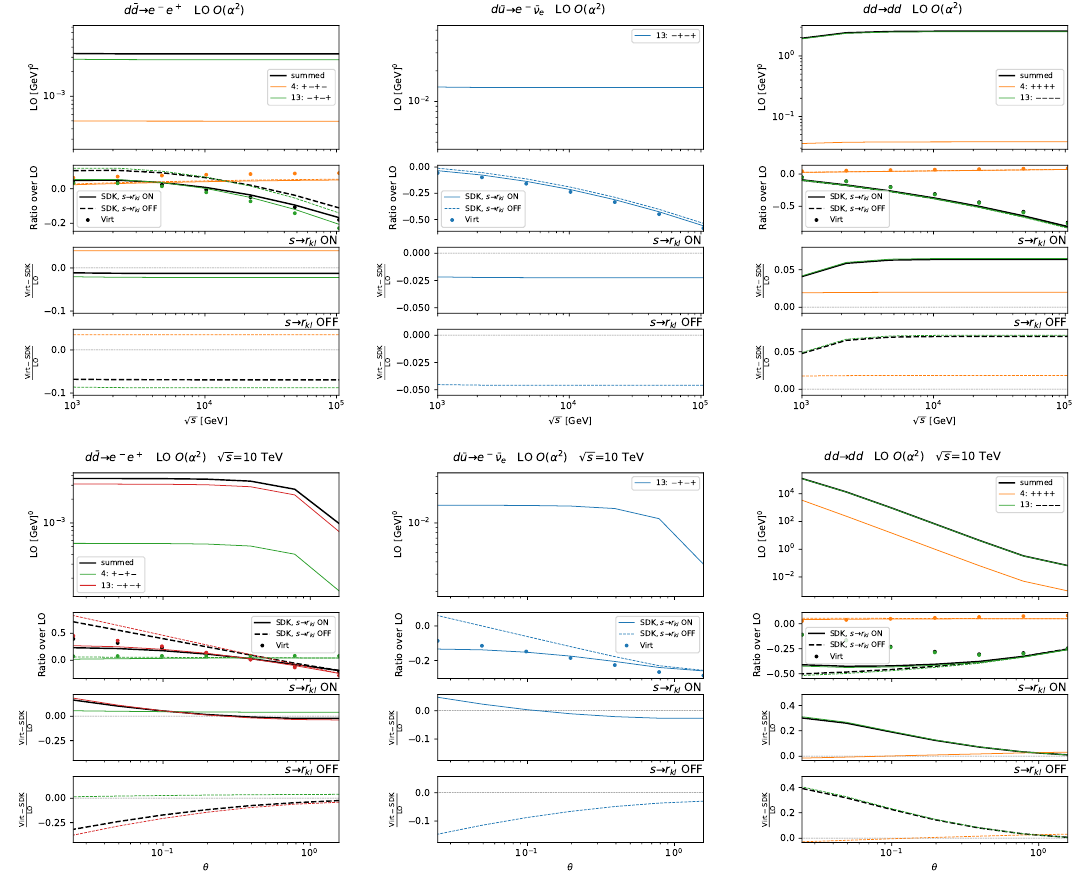
Figure 2 . Same as figure 2, but for a different set of